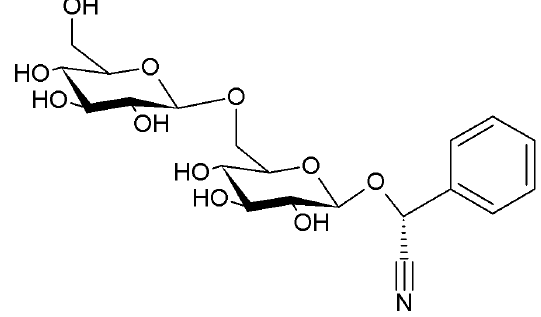
Figure 5. Chemical structure of amygdalin, the major cyanogenic glycoside in Prunus seeds.